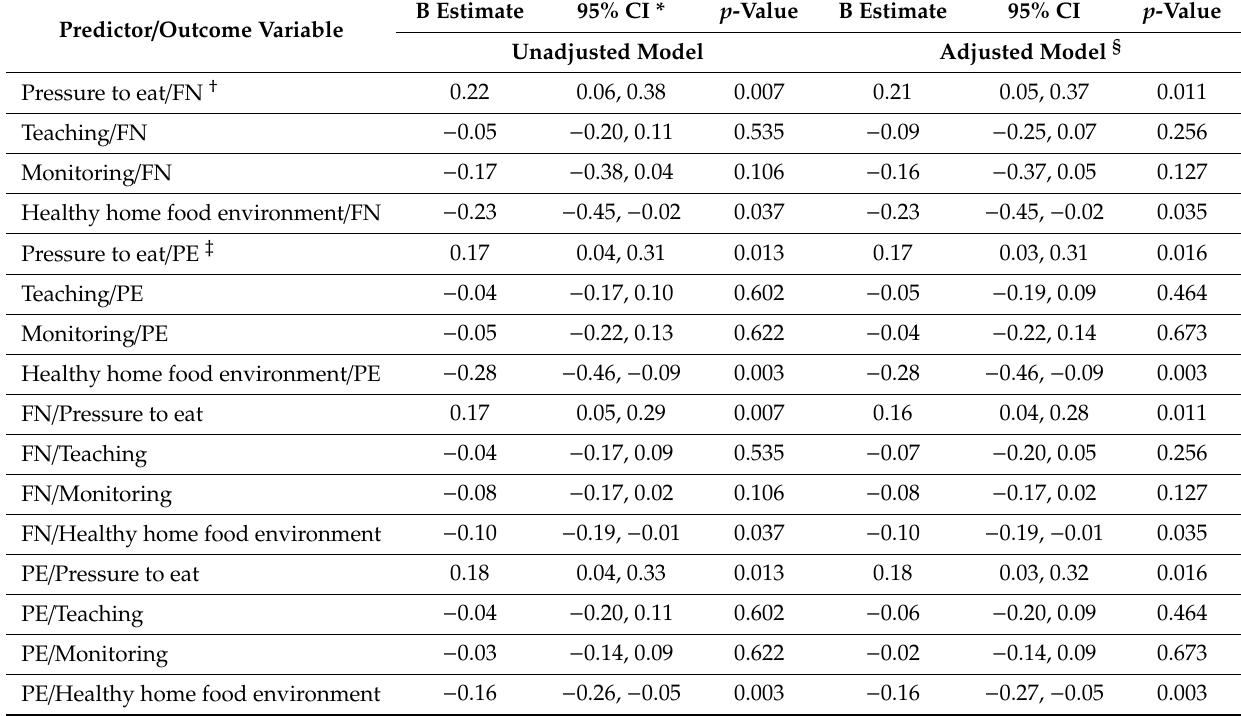
Table 3. Relationships of food neophobia and picky eating with maternal feeding